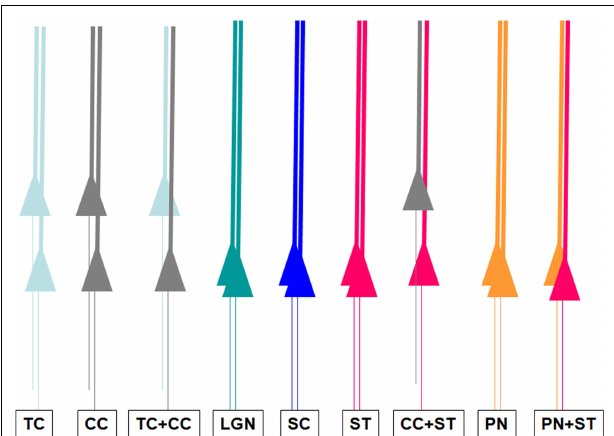
FIGURE 4 | Summary of the different types of dendritic bundles in the visual cortex, related to the axonal targets of their cell body. TC: neurons projecting to the ipsilateral cortex; CC: callosally projecting neurons; LGN: corticothalamic neurons; SC: corticocollicular neurons; ST: corticostriatal neurons; PN: corticopontine